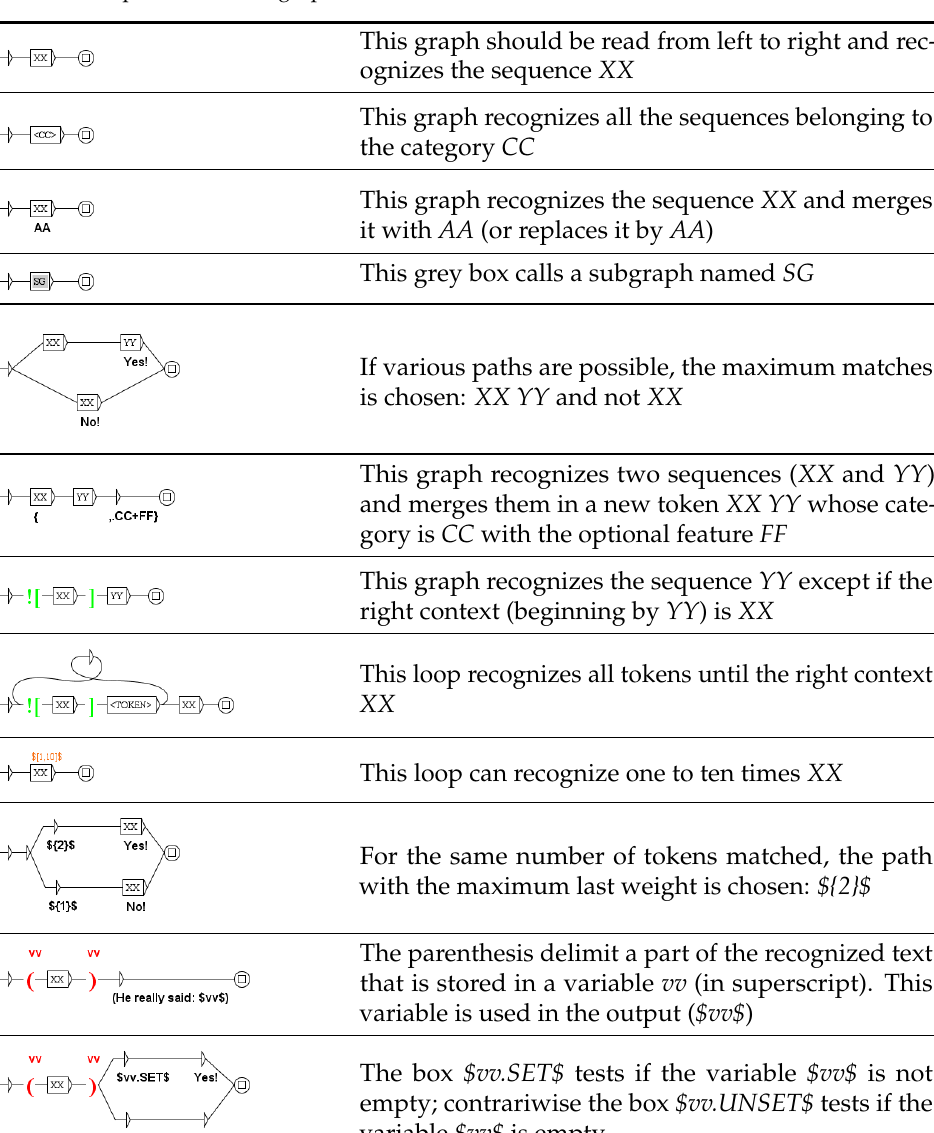
Table 3. Description of Unitex